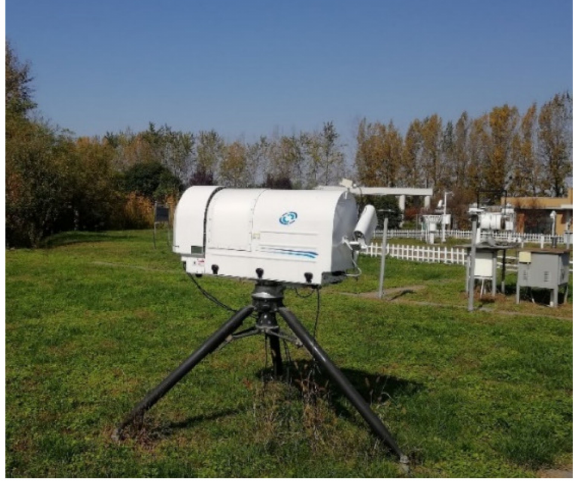
Figure 1. The microwave radiometer (MWP967KV) used in this